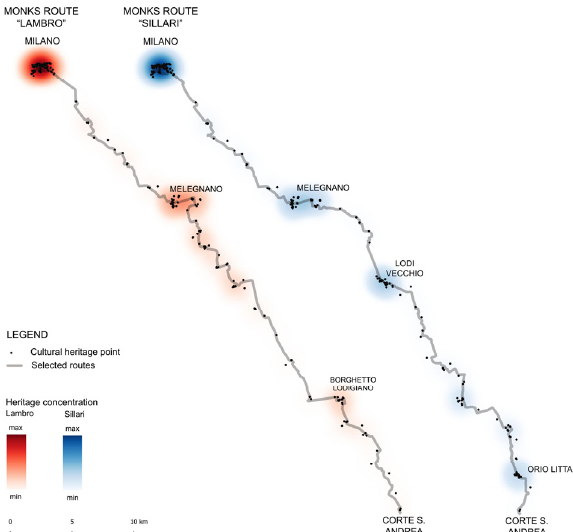
Figure 8. Spatial distribution of cultural heritage points along the itineraries (buffer 500